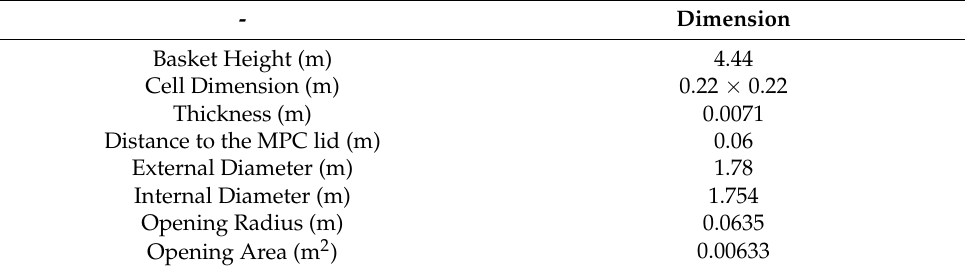
Table 3. The honeycombed fuel basket main dimensions